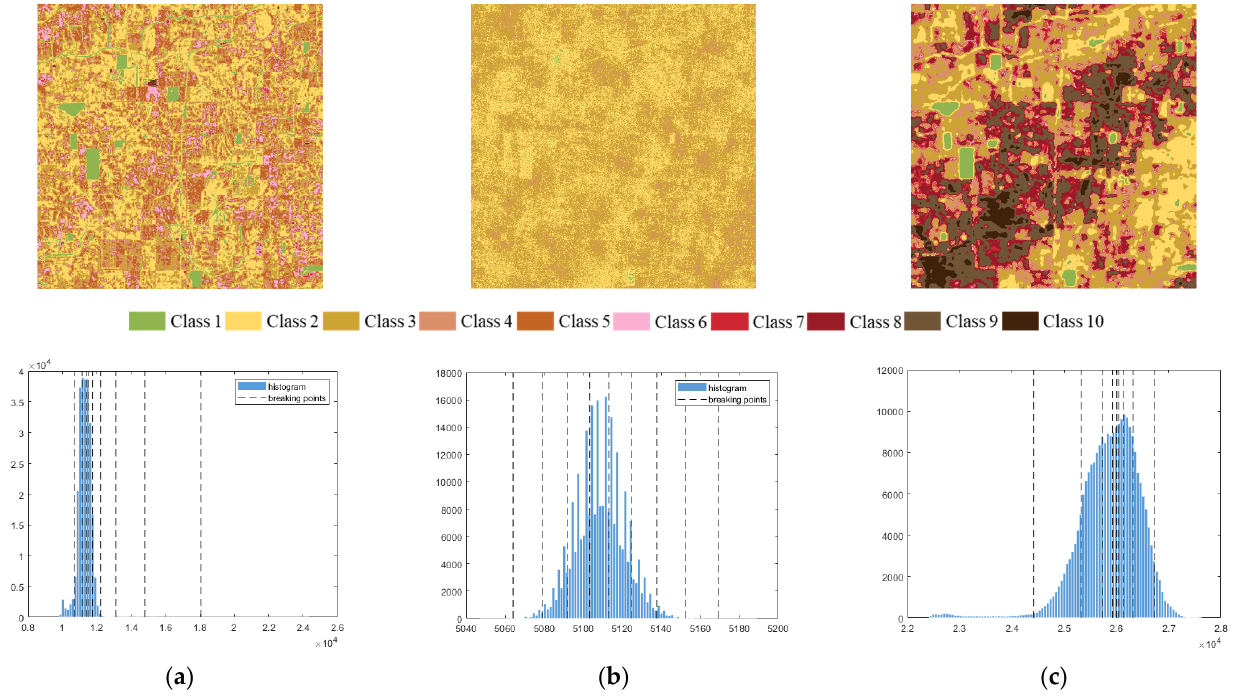
Figure 8. GIC classification results of the Landsat 8 images and corresponding break points for the blue band ( a ), cirrus band ( b ), and thermal band ( c ). blue band ( a ), cirrus band ( b ), and thermal band ( c